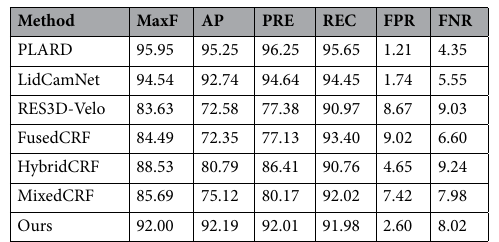
Table 5. Comparison with Several Popular Fusion-based Methods on UU_ROAD (BEV) (/%).